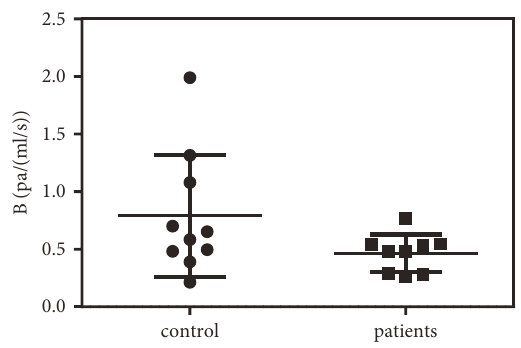
Figure 6: Flow resistance analysis of